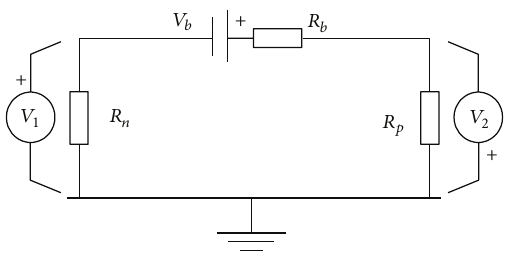
Figure 9: The insulation resistance model.